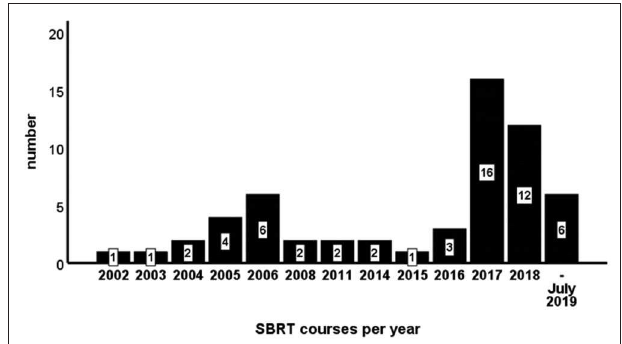
FIGURE 1 | Stereotactic body radiotherapy (SBRT) courses per